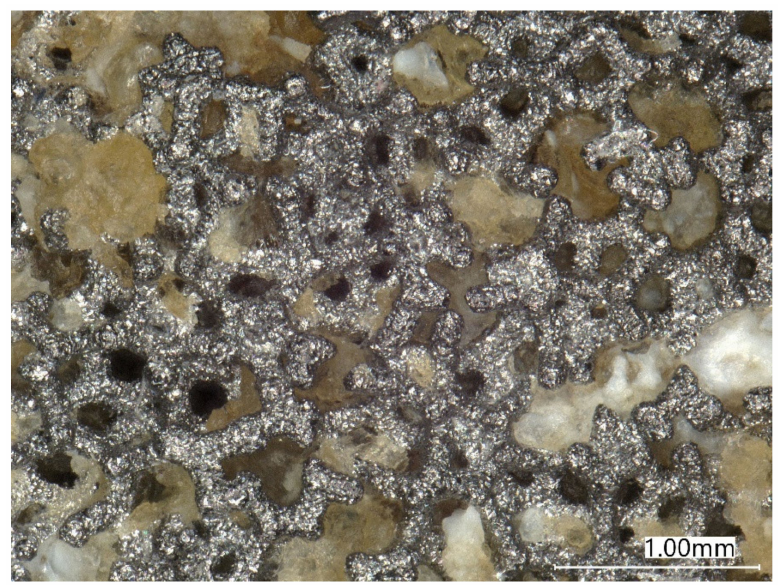
Figure 7. Light microscopy image of the unstained porous tantalum modular tibial tray surface with mostly fibrous tissue (yellow areas) and some bone (white areas) ingrowth.